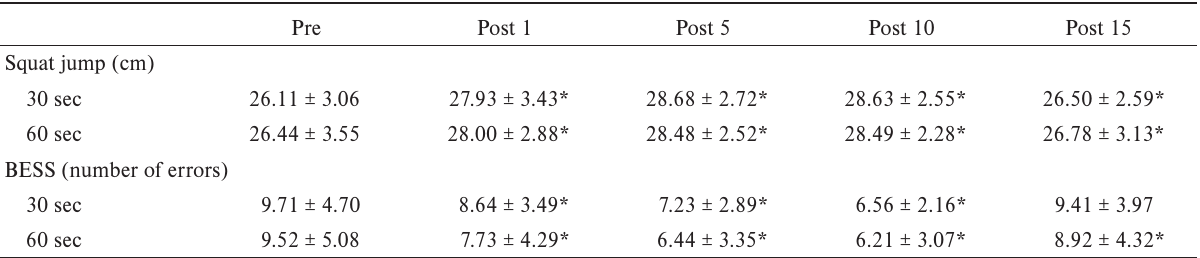
*significant difference with respect to baseline values